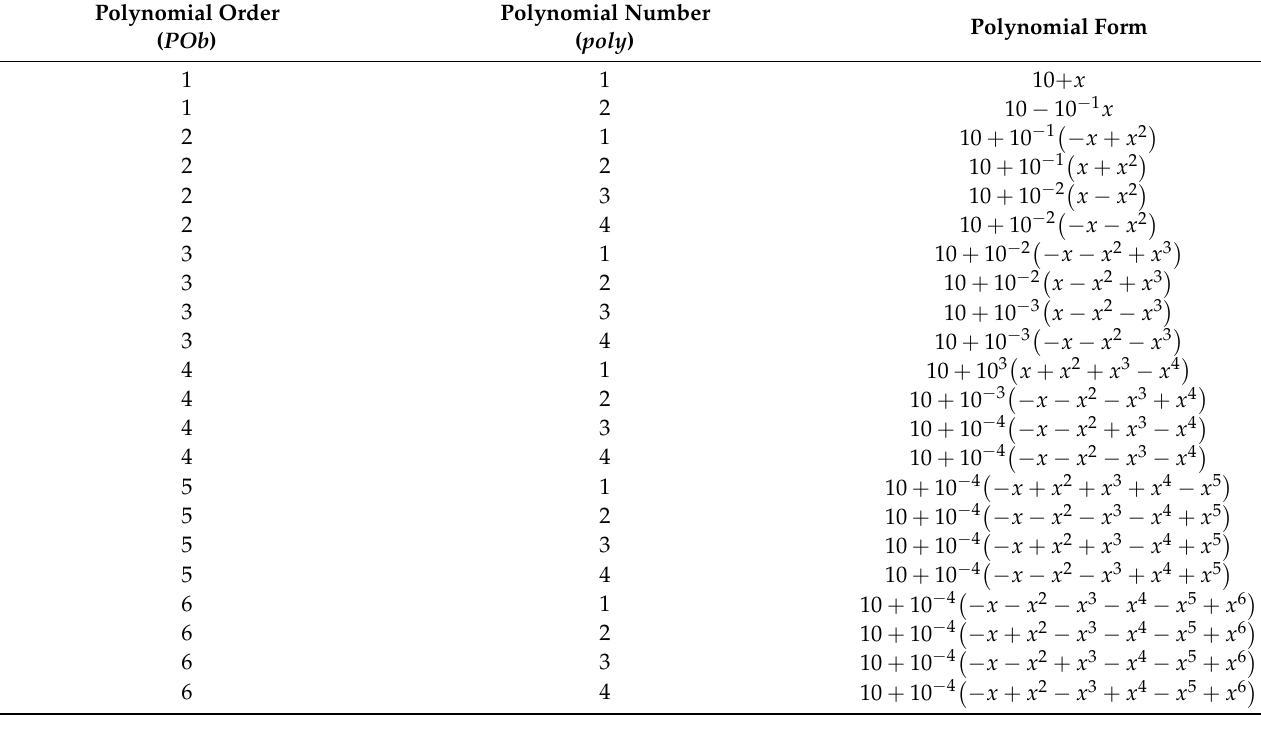
Table 2. Data on the selected reference base polynomials.